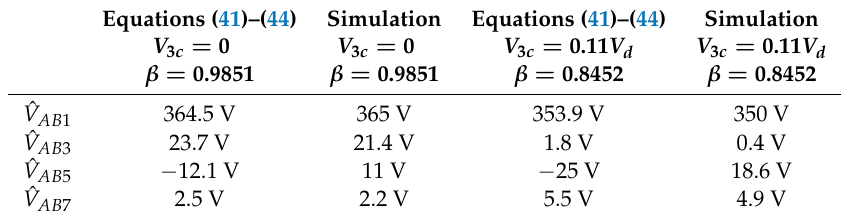
Table 2. Low-Frequency Harmonic Components in Over-Modulation Without- and With Third Harmonic elimination ( m I =